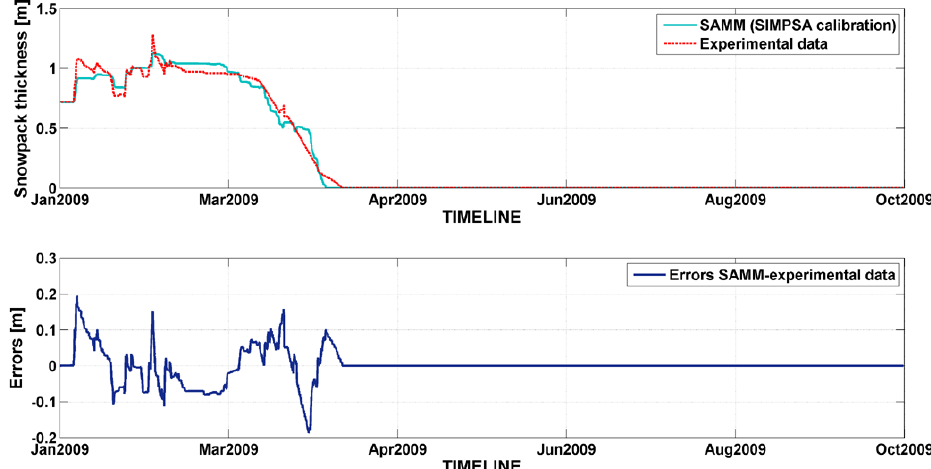
Fig. 4. Calibration of the model with the event January 2009–March 2009 registered by the Doccia di Fiumalbo station, using SIMPSA.